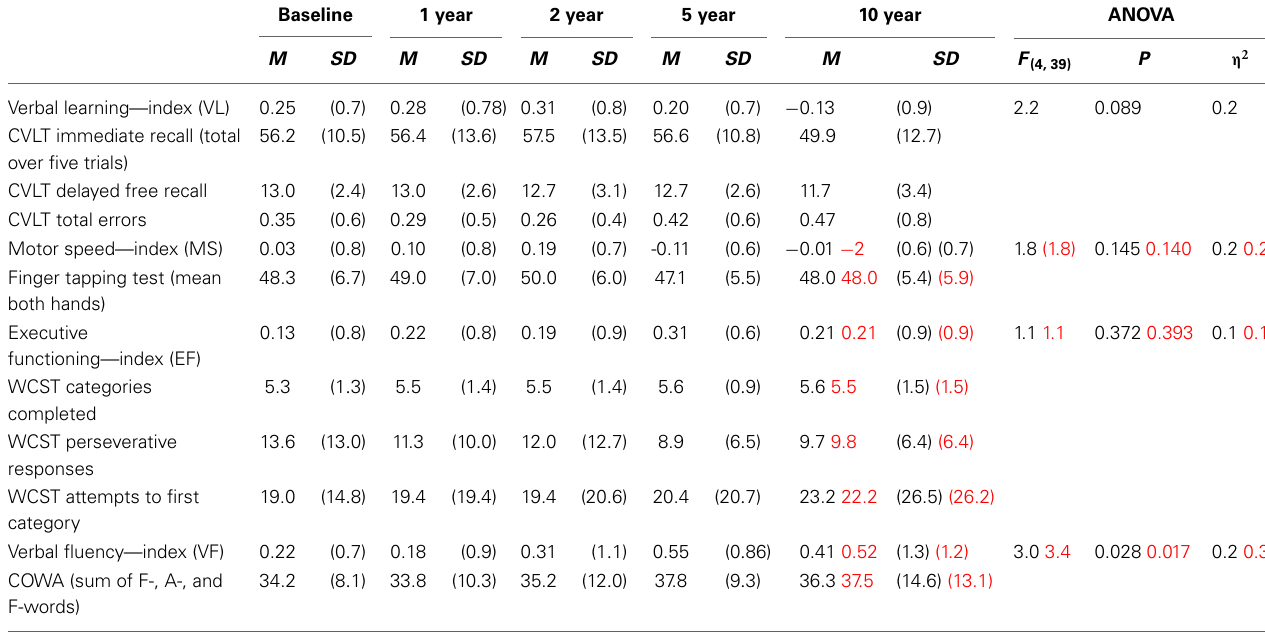
Table 1 | The four neurocognitive indices with the corresponding subtests and raw scores at each time point for the follow-up sample (Corrected numbers in red).